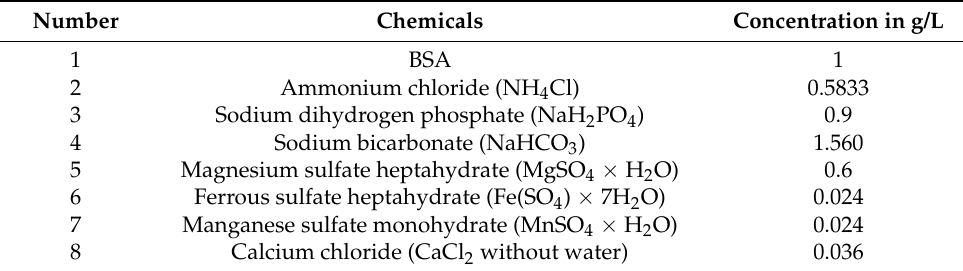
Table 1. Composition of synthetic dairy wastewater (SW-BSA).